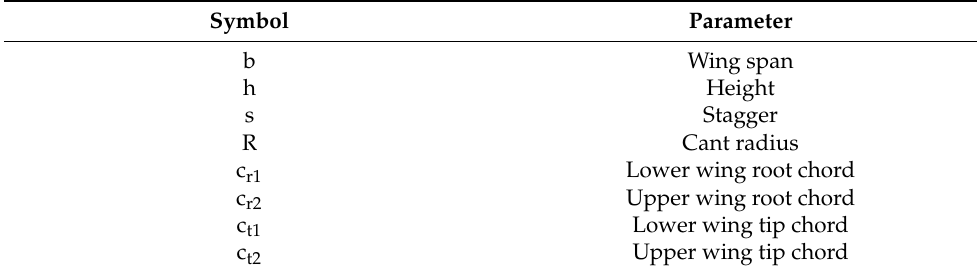
Table 1. Parameterized box wing specification